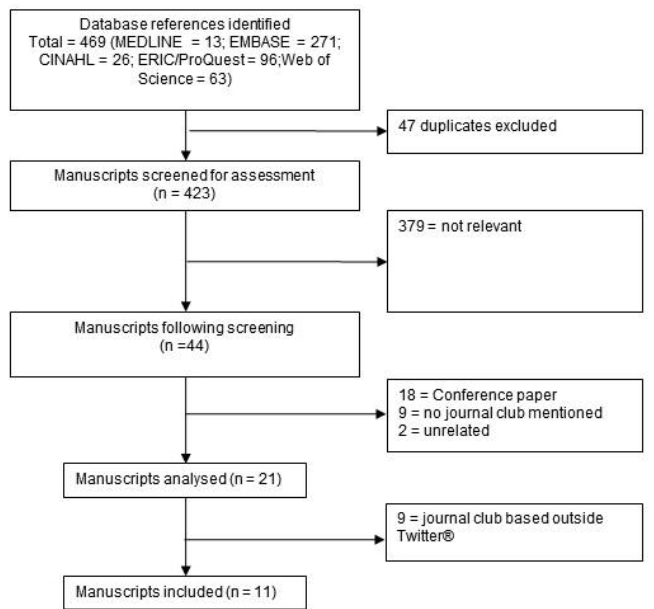
Figure 1. Flowchart of study selection as per the PRISMA statement.